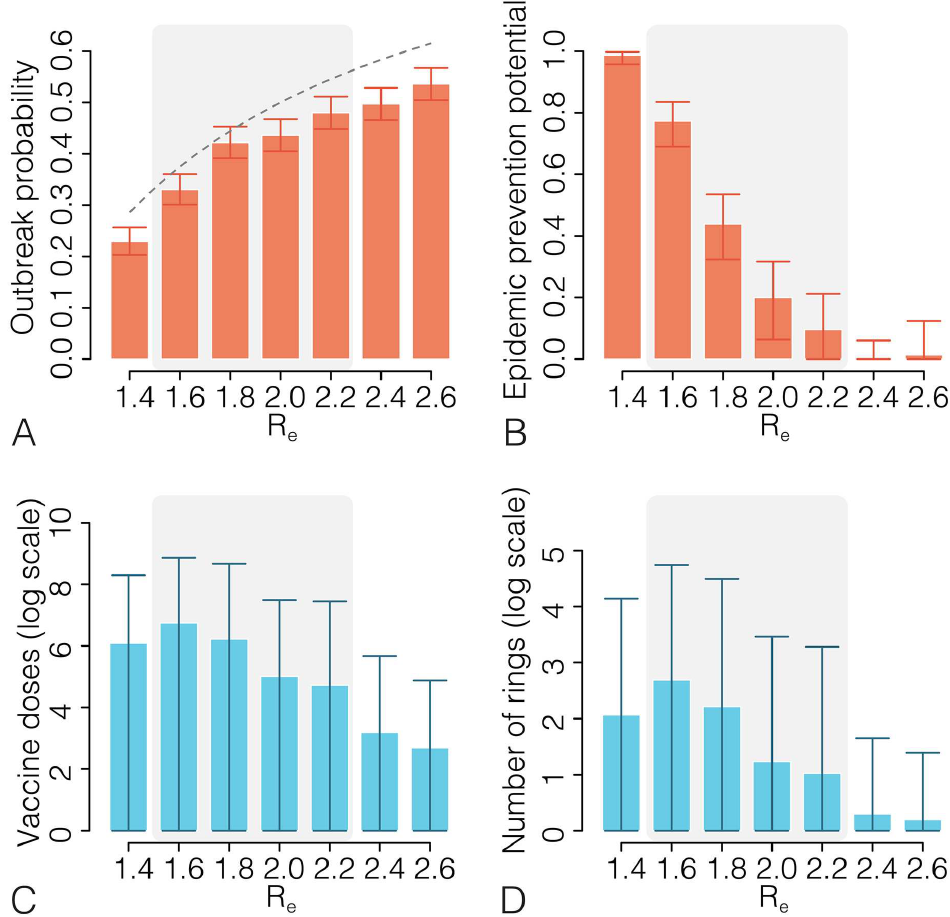
Fig 1. Ring vaccination with baseline parameters. A Probability(with 95%CI; exact binomial test) of an uncontained outbreak (more than 300 cases) after introducingone infected case into a fully susceptible population for a range of R e values. The dashed line represents the theoreticalvalue 1 − 1/ R e under a homogeneous mixing assumption. B Estimated epidemicpreventionpotential and 95%CI for a range of R e values. The shaded grey area denotes the most plausible R e values for the 2014–15West African epidemic. C Mean number of vaccine doses and 95%CIs for containing an outbreak for a range of R e values. D As C but for the number of rings defined. Each estimate is based on 1,000